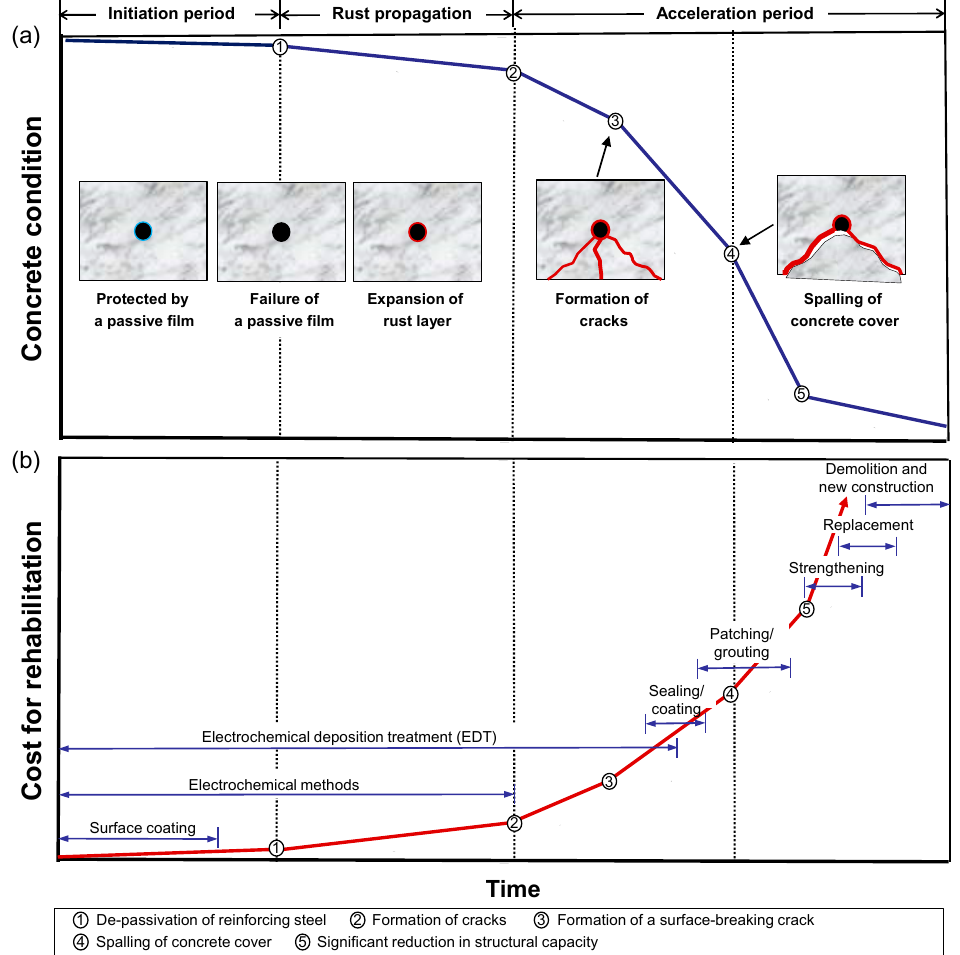
Figure 1. Conceptual illustration of typical deterioration types in reinforced concrete caused by steel corrosion and various rehabilitation methods: ( a ) deterioration process of steel corrosion in concrete and ( b ) effective rehabilitation methods for deteriorated concrete with various severity levels. Corrosion of infrastructures causes high costs to the society of many industrialized countries in the world. Estimated annual direct corrosion cost is about US $240 billion in the US. Approximately 20% of the direct costs were attributed to corrosion of reinforced concrete (highway bridges, parking garages, retaining walls, tunnels, etc.) [6]. More than 55% of structures’ repairs were caused by steel corrosion in Europe [1]. The corrosion cost of the damaged infrastructure is up to 3.8% of the gross domestic product (GDP) of developed countries, and up to 5.2% in the Middle East [7–9]. In Korea, corrosion cost was calculated as 2.9% of GDP [10]. From the perspective of infrastructure management agencies, it is of importance to find effective ways for maintenance of old and/or damaged reinforced concrete structures with corrosion issues, which keeps the structures in sound condition and prolongs their service life, thereby reducing social cost for maintenance of infrastructure